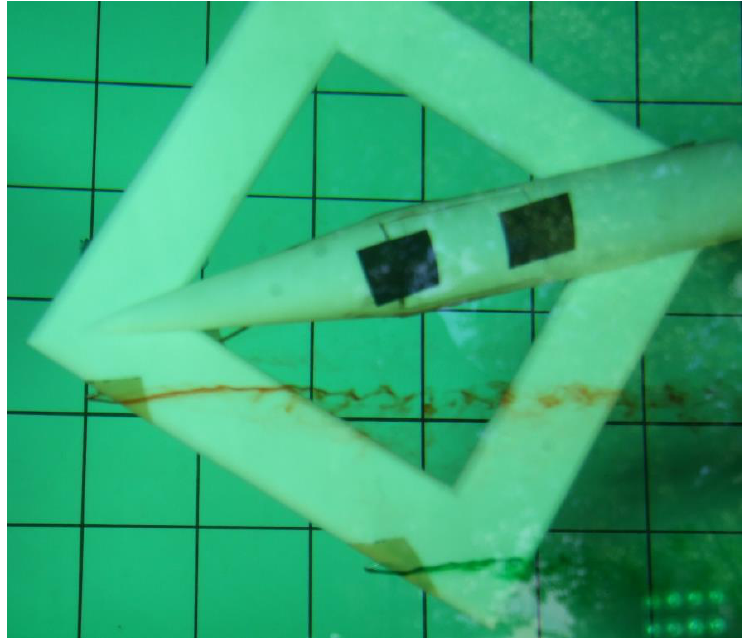
Figure 12. Water tunnel photograph showing turbulent flow falling into the wing in horizontal phase).